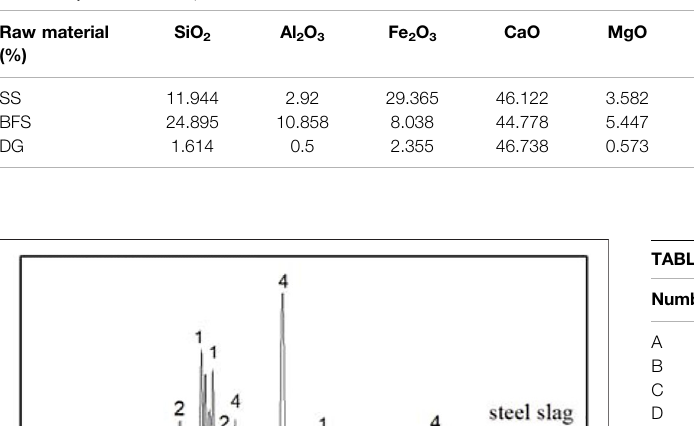
TABLE 1 | Chemical compositions of raw materials.